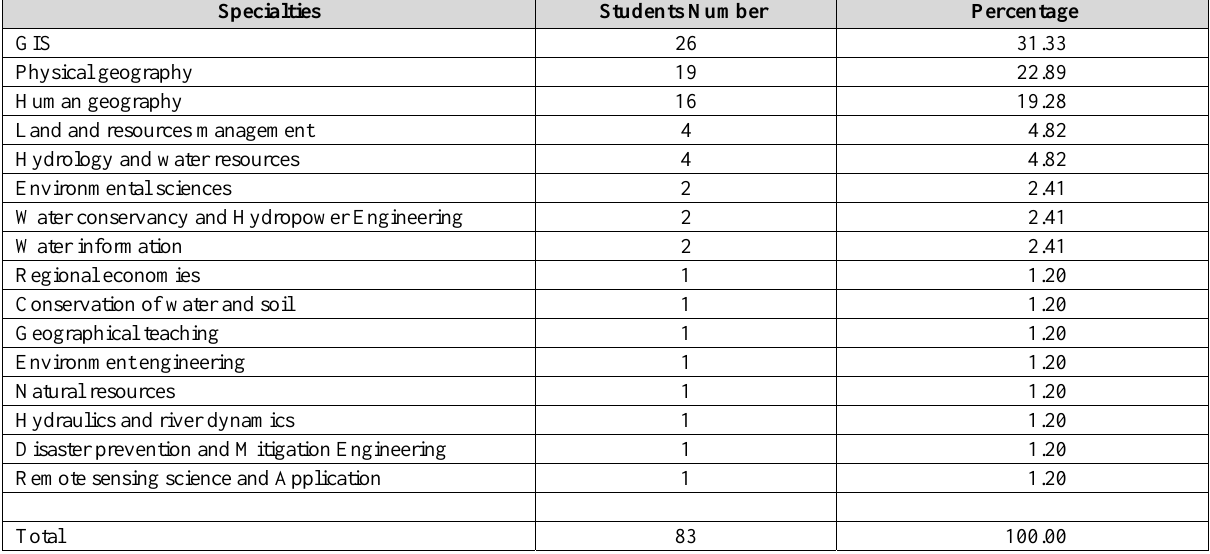
Table 1. The specialties of the students